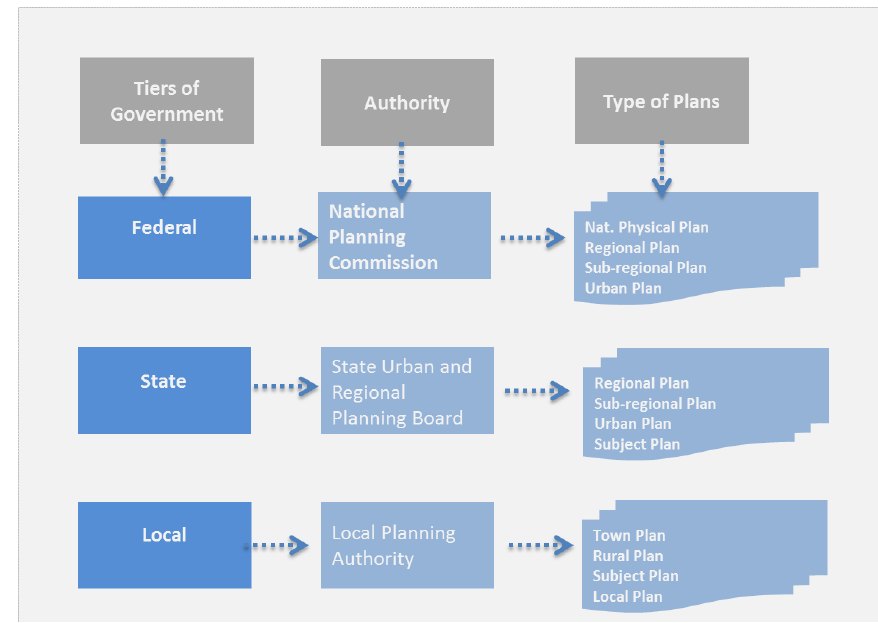
Figure 2: The planning system in